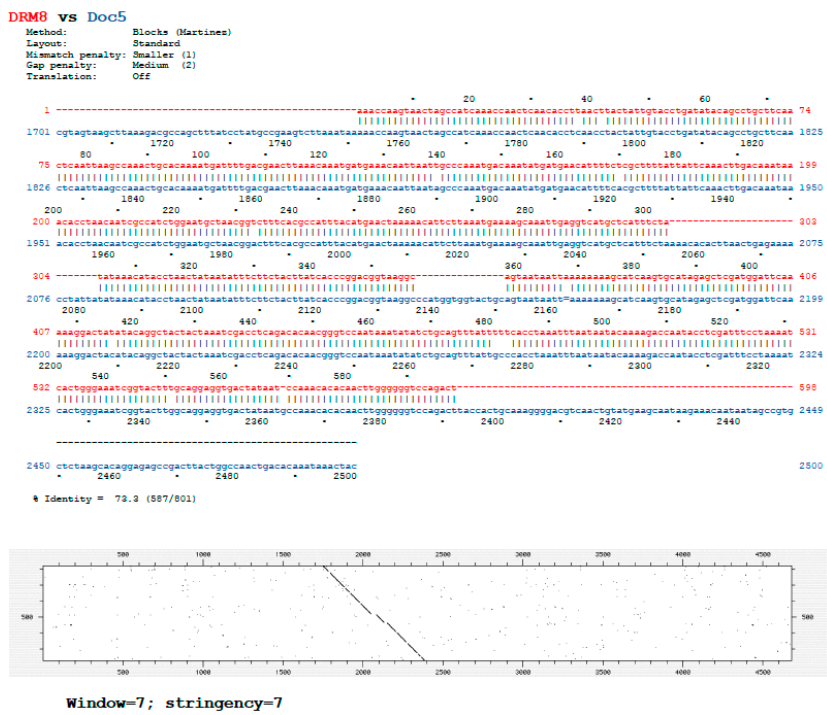
Figure 1. Comparison of the Doc5 reference sequence and the 596 bp sequence identified at both sides of the Bari1 cluster in the h39 region of the chromosome 2 of D. melanogaster . The global sequence alignment ( top ) and the Dot-plot comparison ( bottom ) are shown. Several copies of the Doc5 can be found in the reference genome of D. melanogaster (see Table 2). In silico analyses reveal that Doc5 maps exclusively in the constitutive het- erochromatin of the two major autosomes of D. melanogaster , including the centromere, as well as at the eu-heterochromatin transition. Table 2. The distribution of the Doc5 transposon in the D. melanogaster genome. The Doc5 sequence (596 bp) was used as a query in BlastN analyses against the D. melanogaster reference genome (Release 6). The approximate map positions in the rightmost column were inferred by comparison with the data in [12]. Only alignments longer than 100 bases are shown. Deep het: deep heterochromatin. UNK: unknown map position.